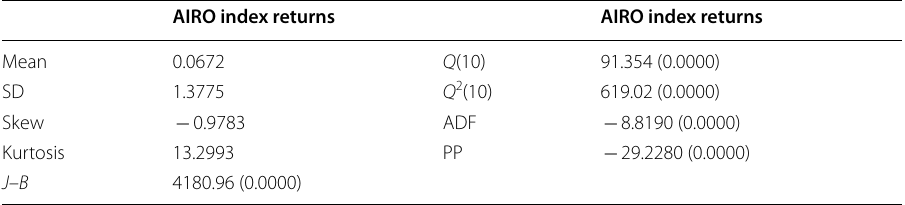
The p values are reported in parentheses. SD represents the standard deviation. J–B is Jarque–-Bera test statistic, with the null hypothesis of normal distribution. Q (10) and Q 2 (10) denote the Ljung–Box Q -statistics of the returns and squared returns series for up to 10th order serial autocorrelation. ADF and PP are the statistics of the augmented Dickey–Fuller and Phillips–Perron unit root tests, respectively, based on lags determined by the Akaike Information Criterion